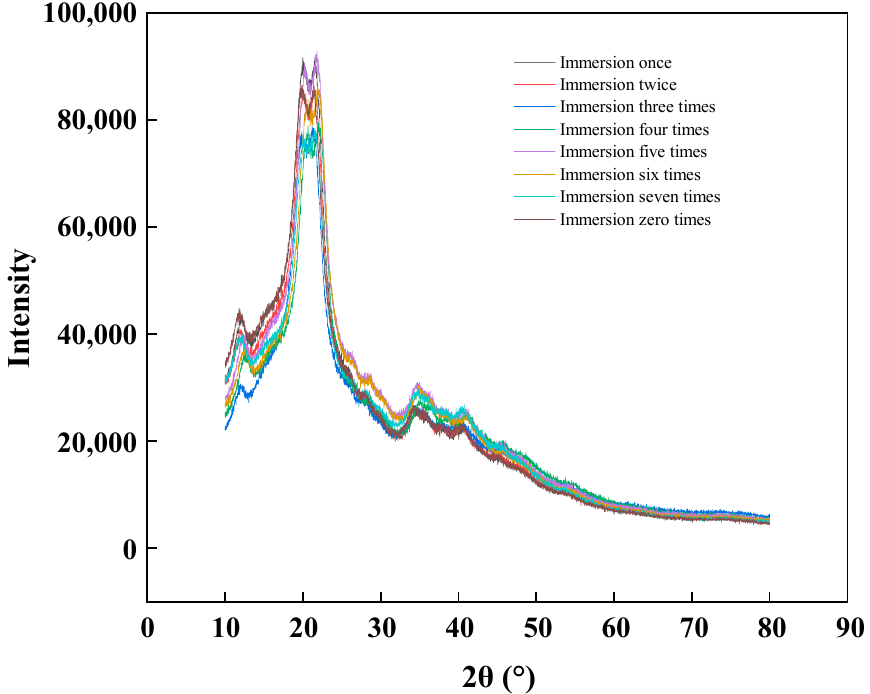
Figure 3. X-ray diffraction images of fabric coated by graphene with different impregnation times.